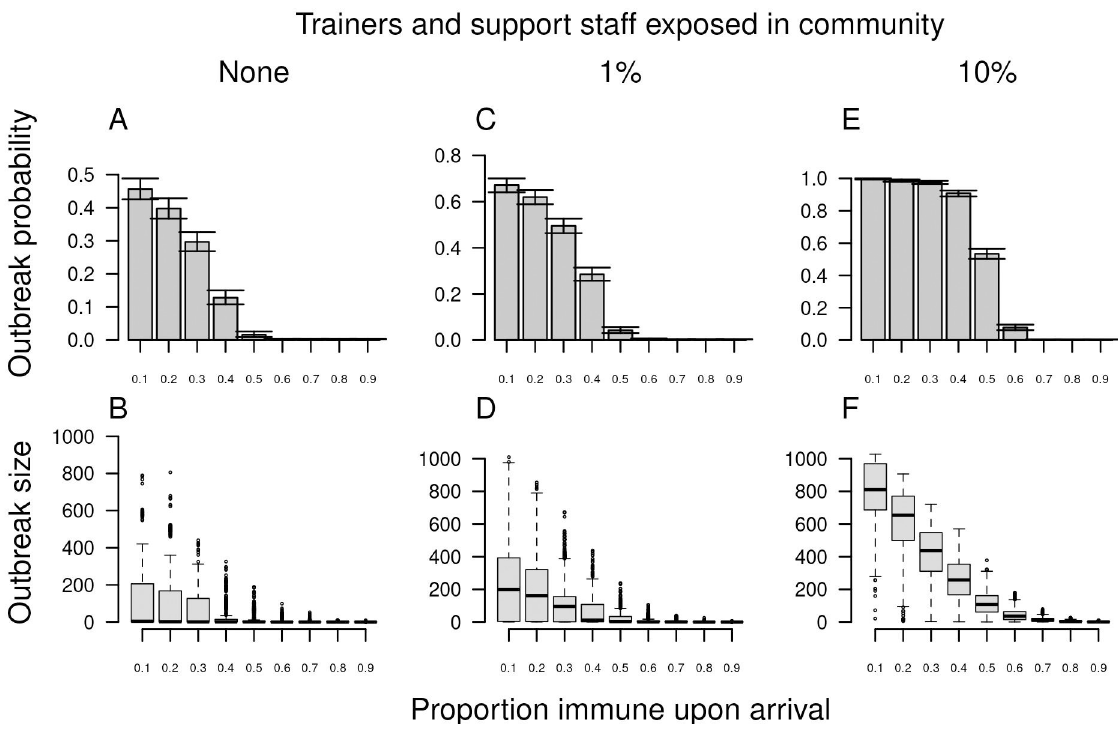
Fig 7. Outbreak probability (top) and size (bottom) in basic training as a function of the proportion immune upon arrival (x-axis). From left to right, columns show increases from 0 to 0.01 to 0.10 of the probability that trainers and support staff were exposed to the virus in the community over the course of the 70-day training period. Error bars for outbreak probability indicate 95% Pearson-Clopper confidence intervals.